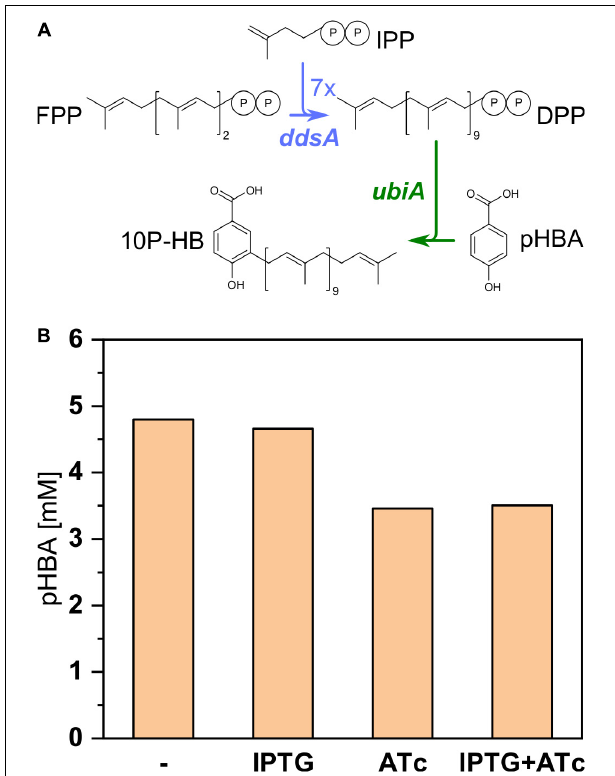
FIGURE 5 | Influence of ubiA expression on pHBA production by the strain UBI400 (pRG_Duet2- ddsA-ubiA ). (A) Pathway from the precursor FPP toward the intermediate 10P-HB with heterologously expressed ddsA and ubiA marked in blue and green, respectively. (B) The expression of ubiA was induced or not induced via addition of ATc either with or without the additional induction of ddsA expression via addition of IPTG. The concentration of pHBA was measured in the respective supernatants. IPP, isopentenyl diphosphate; FPP, farnesyl diphosphate; DPP, decaprenyl diphosphate; DPP, decaprenyl diphosphate; 10P-HB, 3-decaprenyl-4-hydroxybenzoate; ddsA , decaprenyl diphosphate synthase from P. denitrificans ; ubiA , 4-hydroxybenzoate octaprenyltransferase from E. coli